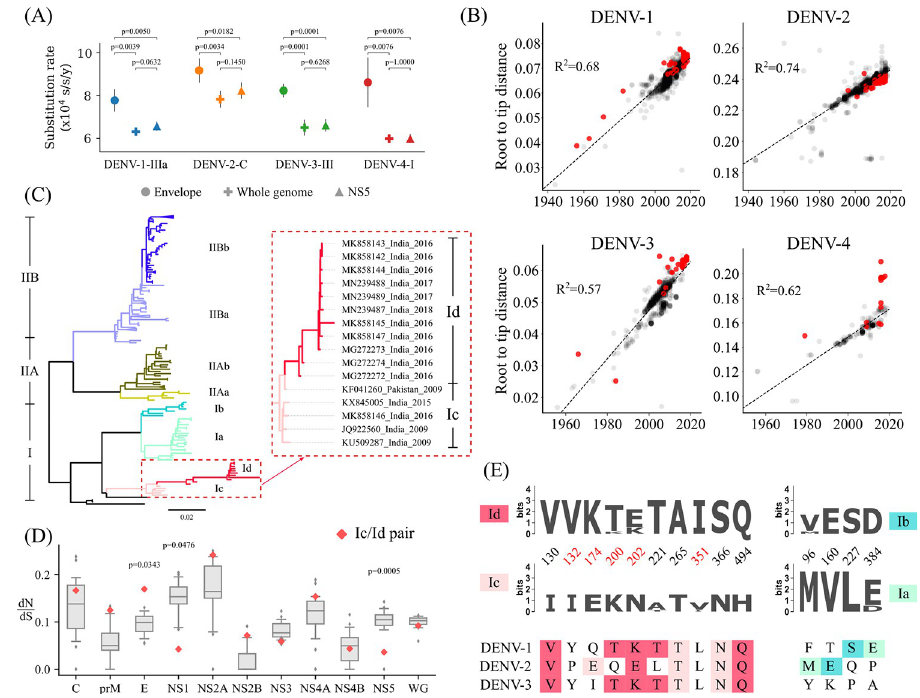
Fig 3. Substitution rates for Indian genotypes and DENV-4-I lineage. (A) Comparison of the substitution rates (substitutions per site per year) for different segments of dengue virus for Indian genotypes. The p -values were obtained using Welch’s t-test (unpaired, two-tailed, unequal variance). (B) Root-to-tip-distance of global dengue whole-genome nucleotide sequences. The Indian sequences are highlighted in red, and the R 2 value for the linear fit is shown. (C) The maximum-likelihood phylogenetic tree for complete coding sequences of DENV-4. Distinct branches (corresponding to Ia/b/c/d, IIAa/b and IIBa/b) used for the dN/dS analysis are colour coded. Indian DENV-4 cluster is shown in the inset. (D) dN/dS values for the consensus sequences generated from the branches in (C) are represented as a box plot for each gene. Whiskers denote the 5 th and 95 th percentile. The dN/dS values for Ic/d pair are marked in red. The generalized extreme Studentized deviate test was performed to find the outliers, and p -values are reported. (E) Sequence logo showing the amino acid variations between pairs Ic/d and Ia/b. The amino acids at these locations for DENV-1-3 are shown at the bottom. Highlighted colour depicts the DENV-4 branch with the same amino acid residue.